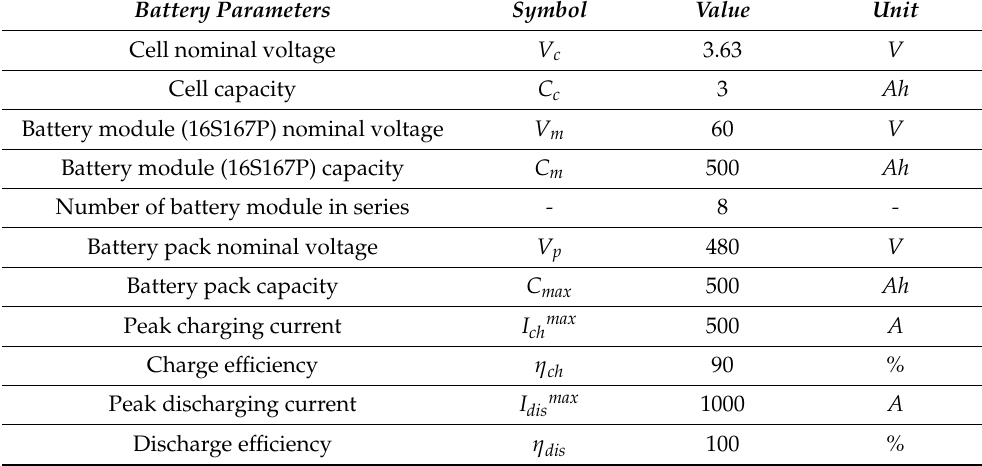
Table 2. Battery parameters. Battery